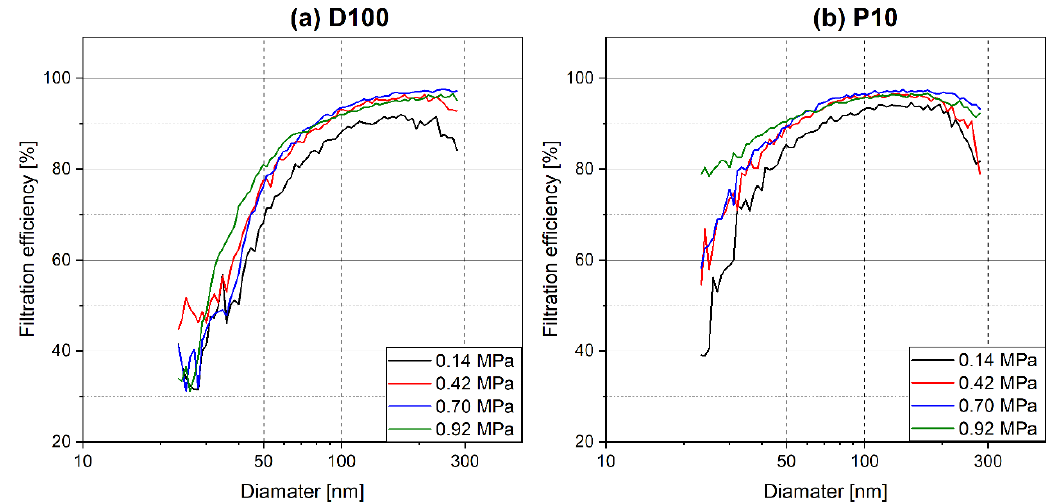
Figure 2. Size-dependent particulate number removal efficiency under various engine loads for ( a ) D100 and ( b ) P10.